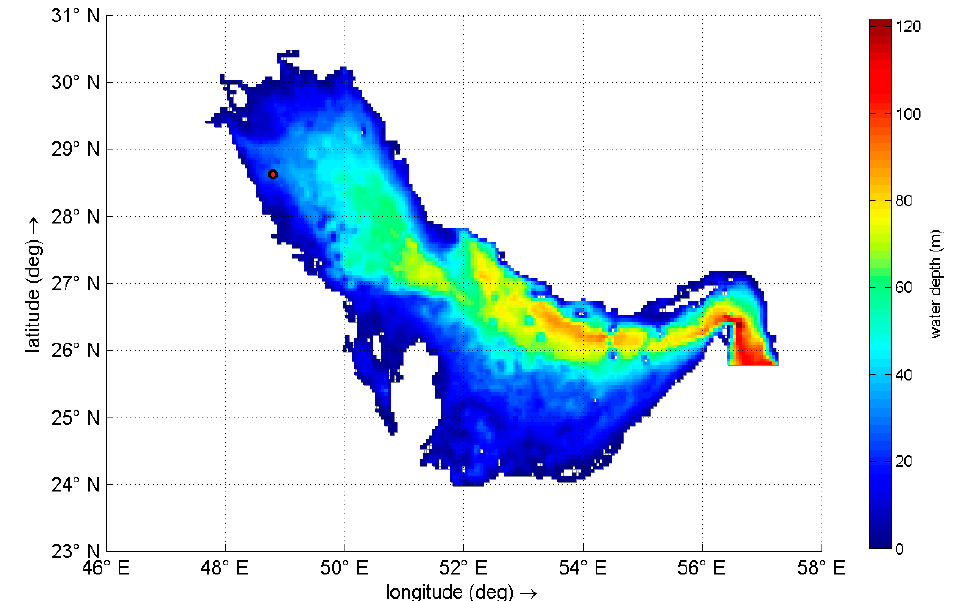
Figure 5. Delft3D Arabian Gulf Model (AGM) computational domain. The colors of the regions indicate the local water depth. The model grid covering the entire domain comprises 194 × 132 × 10 grid cells, with a 4 km horizontal resolution. Location of the current meter in the northeastern Gulf is shown by the red dot.